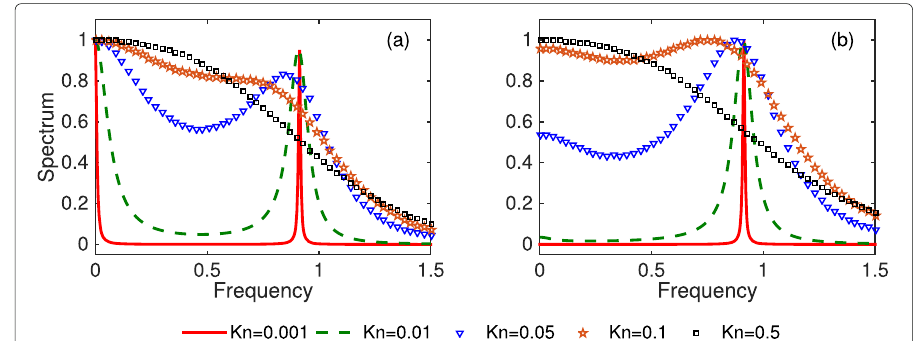
Fig. 2 Spectra of the ( a ) spontaneous and ( b ) coherent RBS from the LBE for Maxwellian gases. Note that in this figure and following figures, each spectrum has been normalized by the maximum value, where the frequency has been normalized by v m / L . Due to the symmetry S ( Kn , f s ) = S ( Kn , − f s ) , only half of the spectrum is